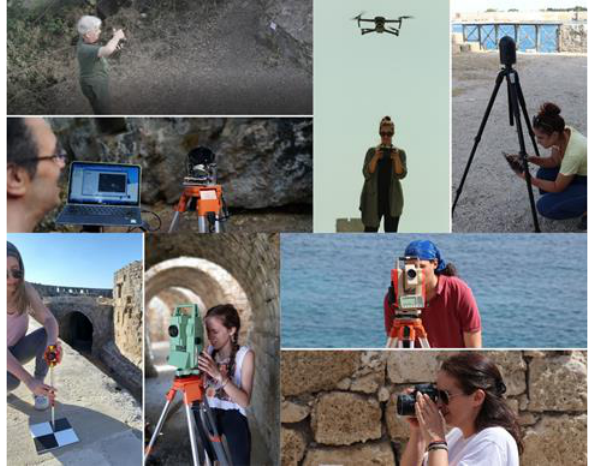
Figure 3 . Field work for the data acquisition.